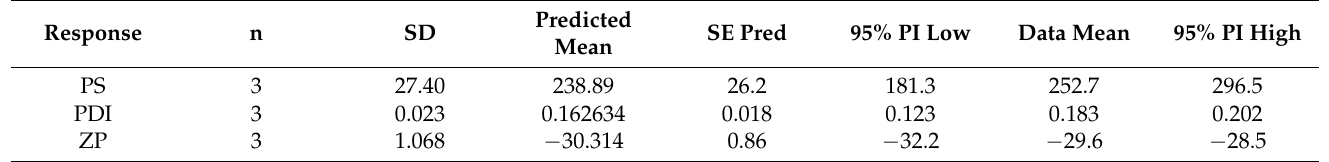
Table 4. Validation of the experimental design model (SL/LO = 3, Plain-NLC (LCFA) ).